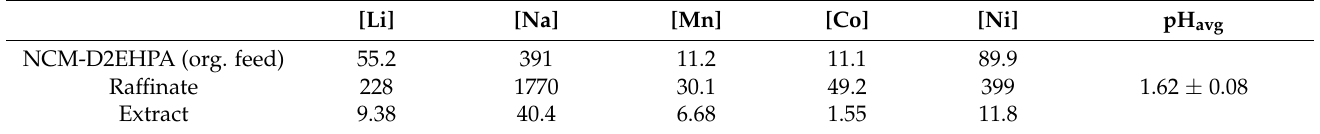
Table 5. Compositions of the extract and raffinate in continuous stripping of Ni, Co, Mn, Li, and Na from 0.8 M NCM-D2EHPA with 3 M H 2 SO 4 . S/F = 10; T = 21 ± 1 ◦ C; τ mix = 7.3 min. Concentrations in [mmol L − 1